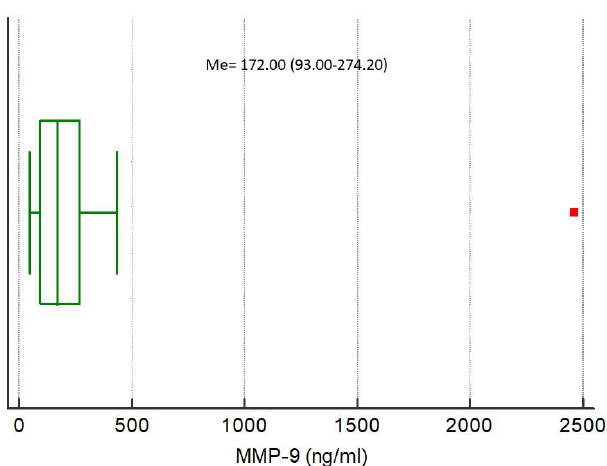
Figure 4. Distribution of the S100 calcium-binding protein B (S100B) concentrations in the study population . Circles and squares indicate outliers and far out values illustrated as single data points.